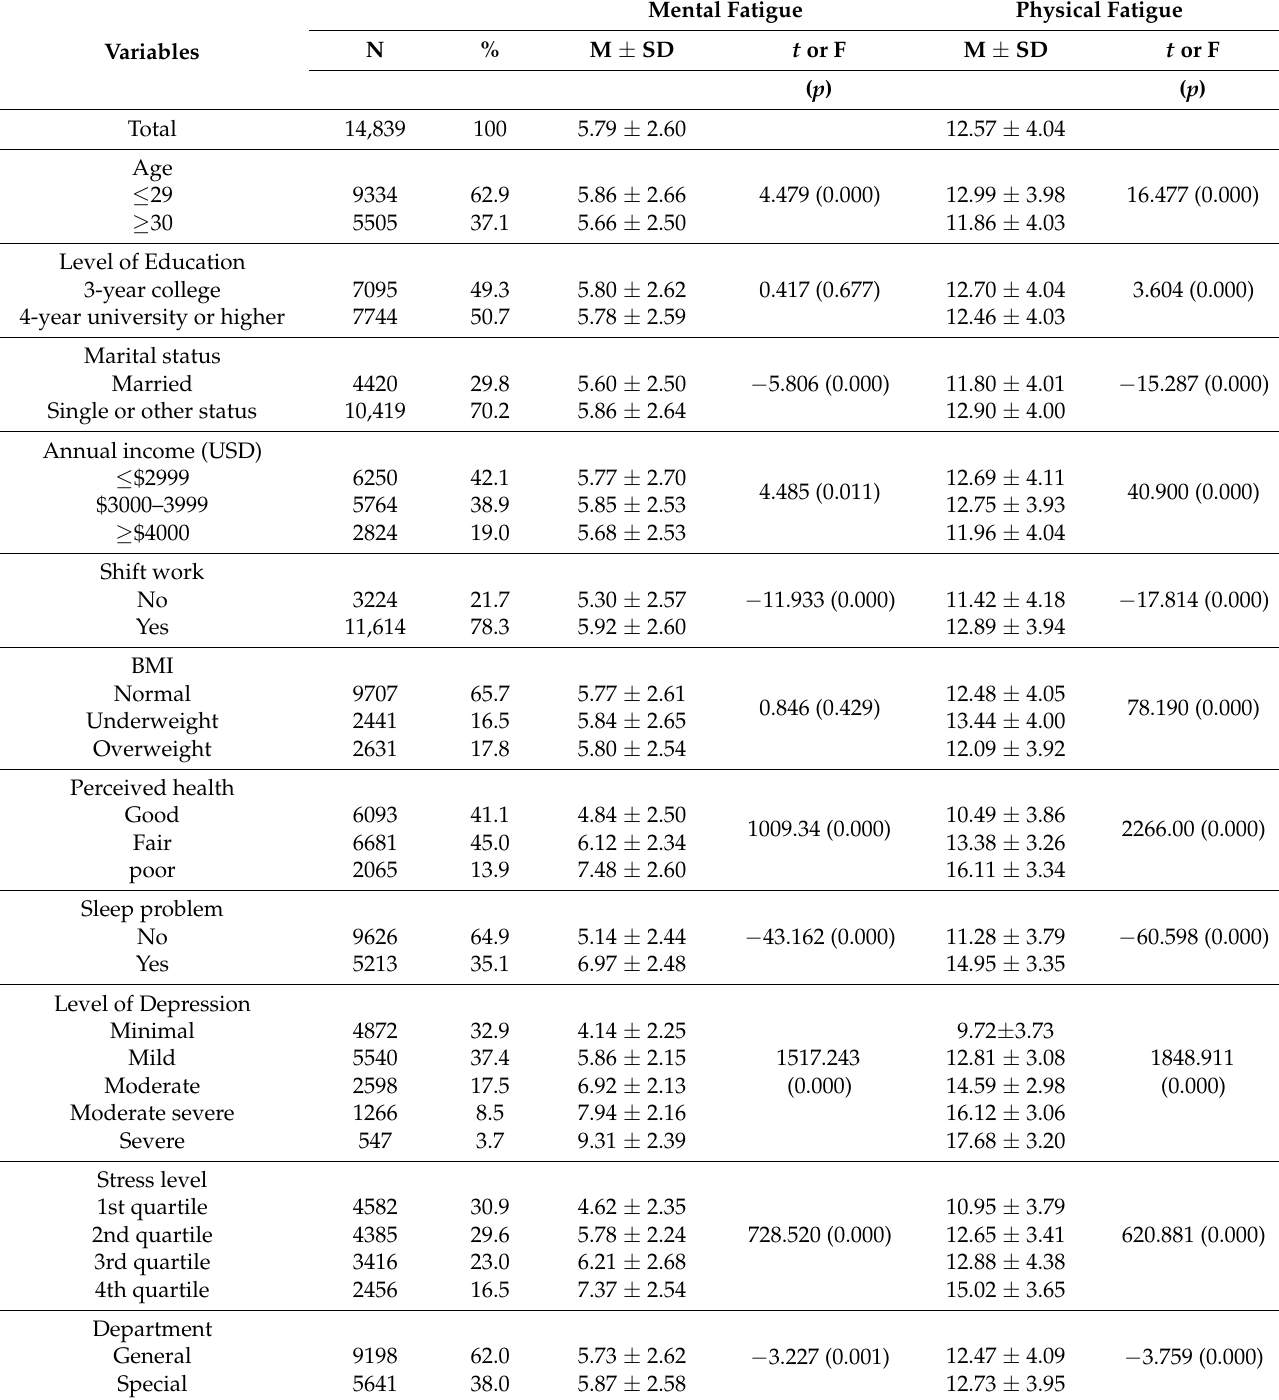
Table 1. General characteristics of participants ( N =